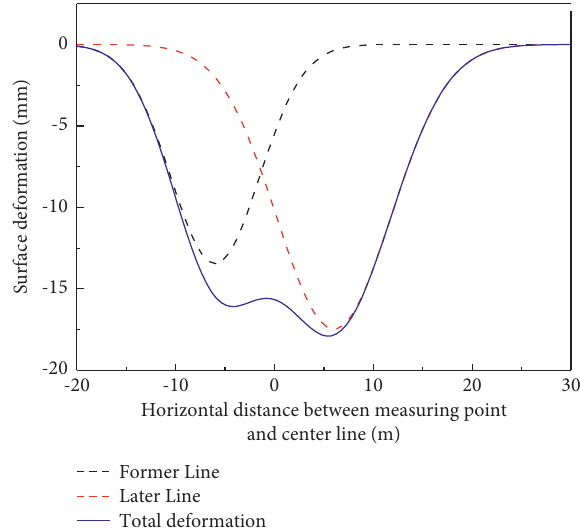
Figure 10: Prediction of surface deformation of section